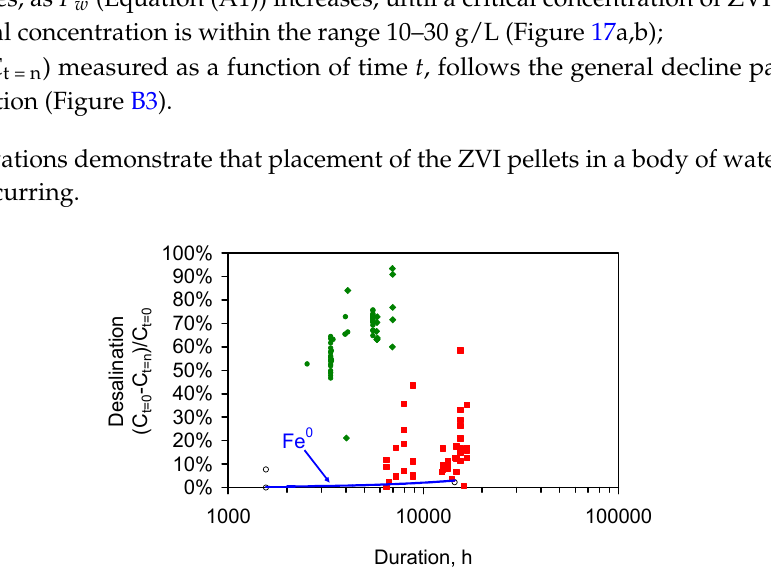
Figure B2. Desalination associated with ZVI catalyst pellet desalination. Type A catalyst (ST) [16]. n = 59; ( a ) Feed Water Salinity vs. Product Water Salinity; ( b ) Feed water salinity vs. Log 10 Rate Constant, k 10 . Red lines indicate the upper and lower bounds of the data set. The black line is the regression trend. Data: [16].